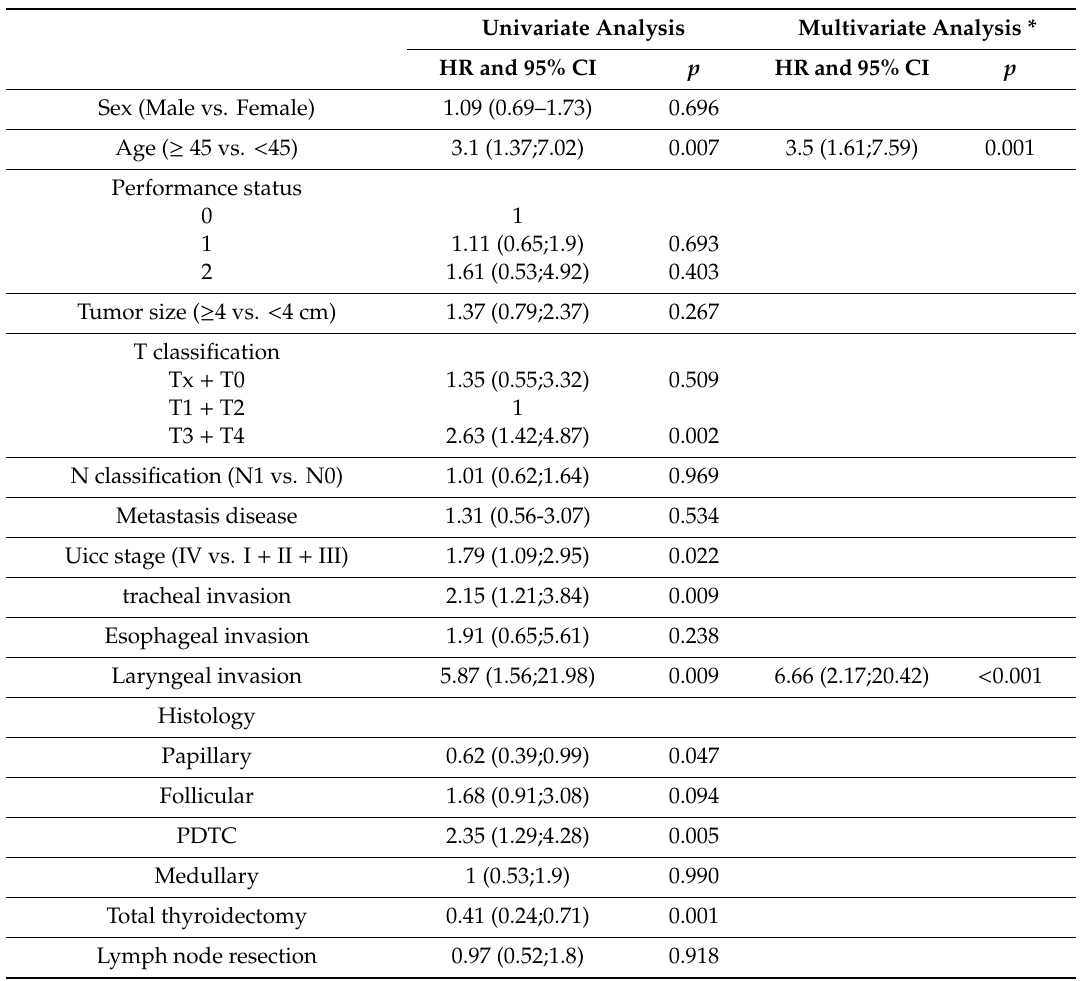
Table 3. Prognostic factors of overall survival after multiple imputations in univariate and multivariate analyses in the external beam radiotherapy (EBRT)